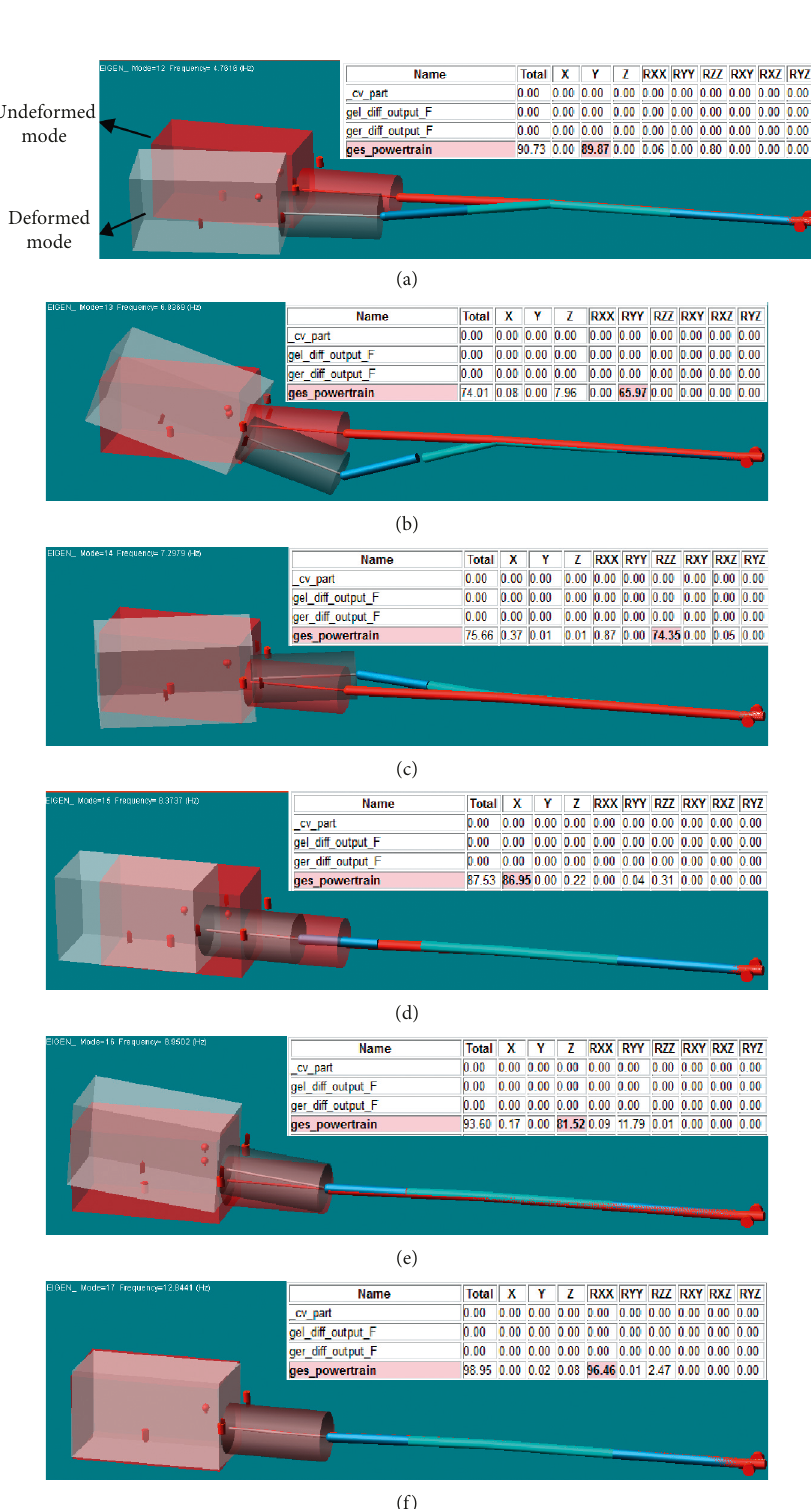
Figure 6: Modal kinetic energy distribution ratio and decoupling rate in all directions of the engine in powertrain system, which includes the decoupling rate on (a) Y direction, (b) Ryy direction, (c) Rzz direction, (d) X direction, (e) Z direction, and (f) Rxx Furthermore, after replacing the damping matching By extracting the attribute value corresponding to the characteristic curve shown in Figure 9 on the whole local optimal point on each response surface, the optimal vehicle model, in order to verify the influence of the matching characteristic curve is obtained and shown in matching characteristic curve with the steering wheel as Figure 9.